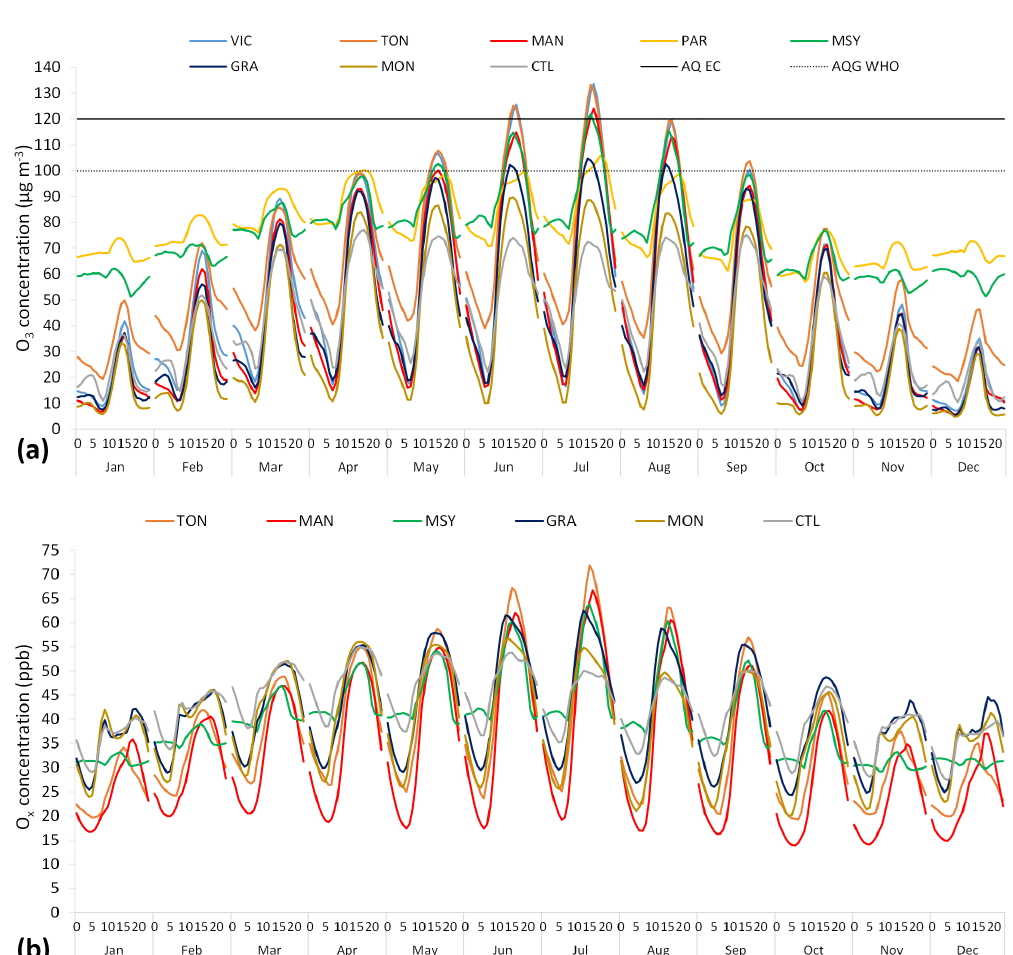
Figure 6. Monthly hourly average concentrations of O 3 (a) and O x (b) along the S–N axis during 2005–2017. Data from Ciutadella (CTL), Montcada (MON), Granollers (GRA), Montseny (MSY), Tona (TON), Vic (VIC), Manlleu (MAN) and Pardines (PAR) air quality monitoring